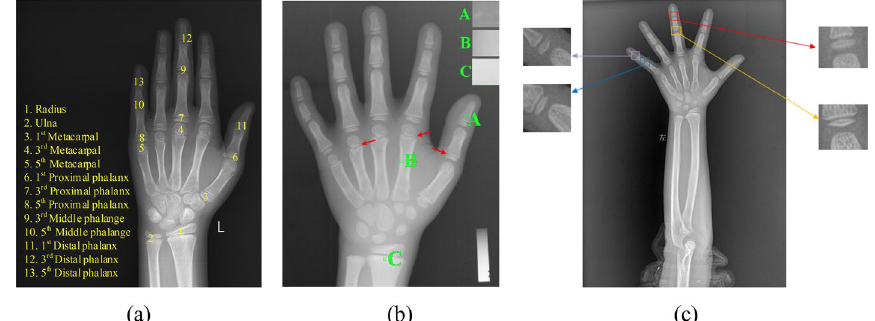
Fig. 2 Example of bones selected in the proposed method. a 13 ROIs for BAA. b Red arrow marks the soft tissue area with great difficulty in segmentation, and green sampling points mark the gray distribution